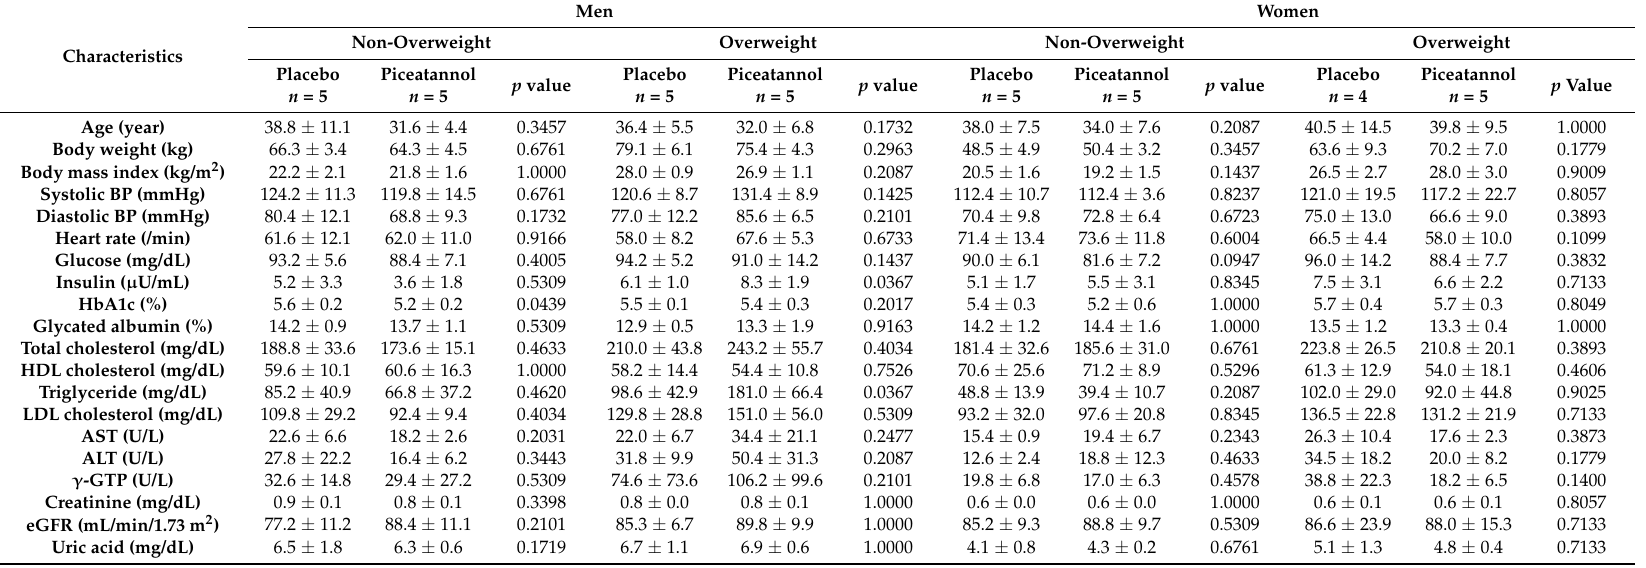
Table 1. Baseline